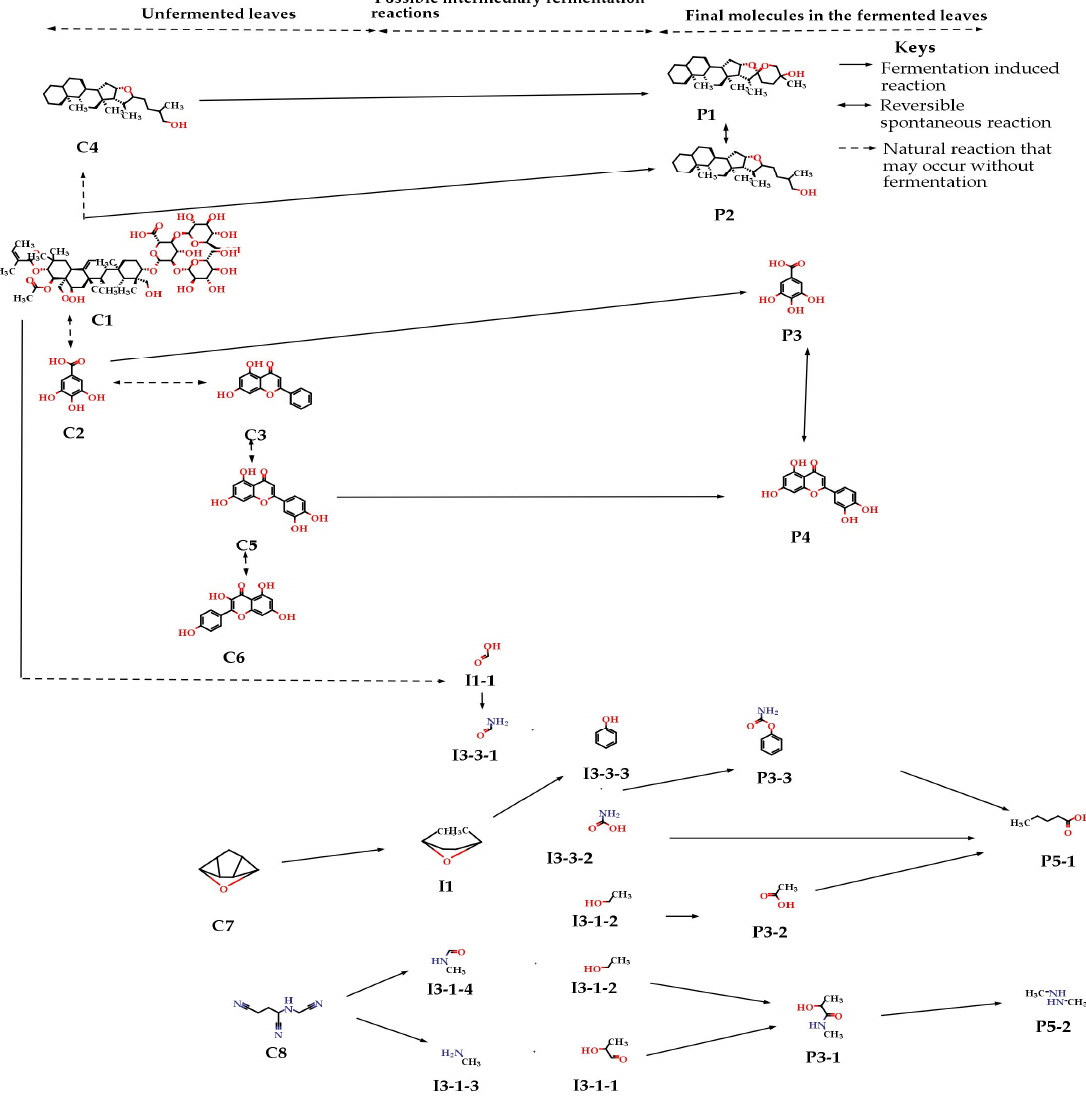
Figure 3. The proposed mechanisms for the E. faecalis -induced biotransformation during fermentation of the leaves of S. monostachyus . Keys: P1 : spirostanol (20.7%); P2 : furostanol (19.9 mg/10 g); P3 : gallic acid (99.0 mg/10 g); P4 : luteolin (1.0 mg/10 g); P3-1 : 2-Hydroxy-N-methylpropanamide (24.7%); P3-2 : ethanoic acid (28.1%); P3-3 : phenyl carbamate (47.1%); P5-1 : valeric acid (13.0%); P5-2 : 1,2-Dimethylhydrazine (87.0%); I1 : 2,5-dimethyloxolane; I1-1 :